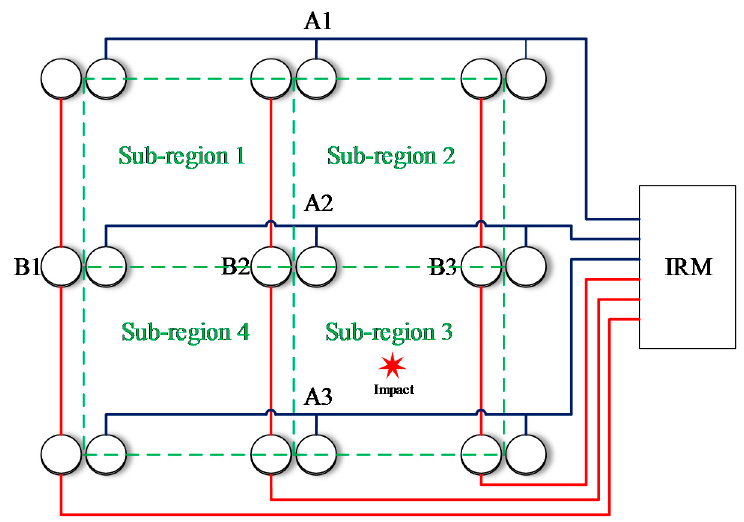
Figure 13. Schematic diagram of the sensor network for illustrating the impact region localization method based on the CSSN and CPSN.